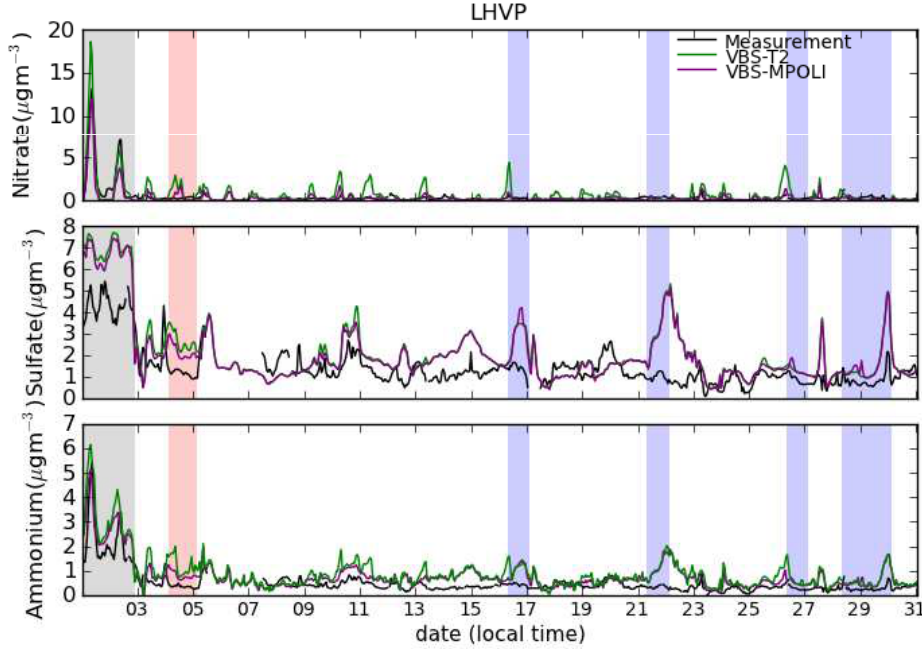
Fig. 6. Comparison of simulated and observed inorganic aerosol species at Fig. 6 Comparison of simulated and observed inorganic aerosol species at LHVP